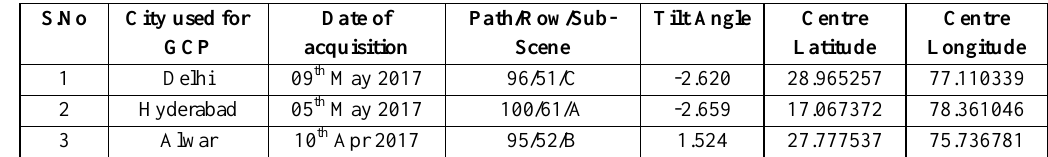
Table 1: Data Products used for evaluation